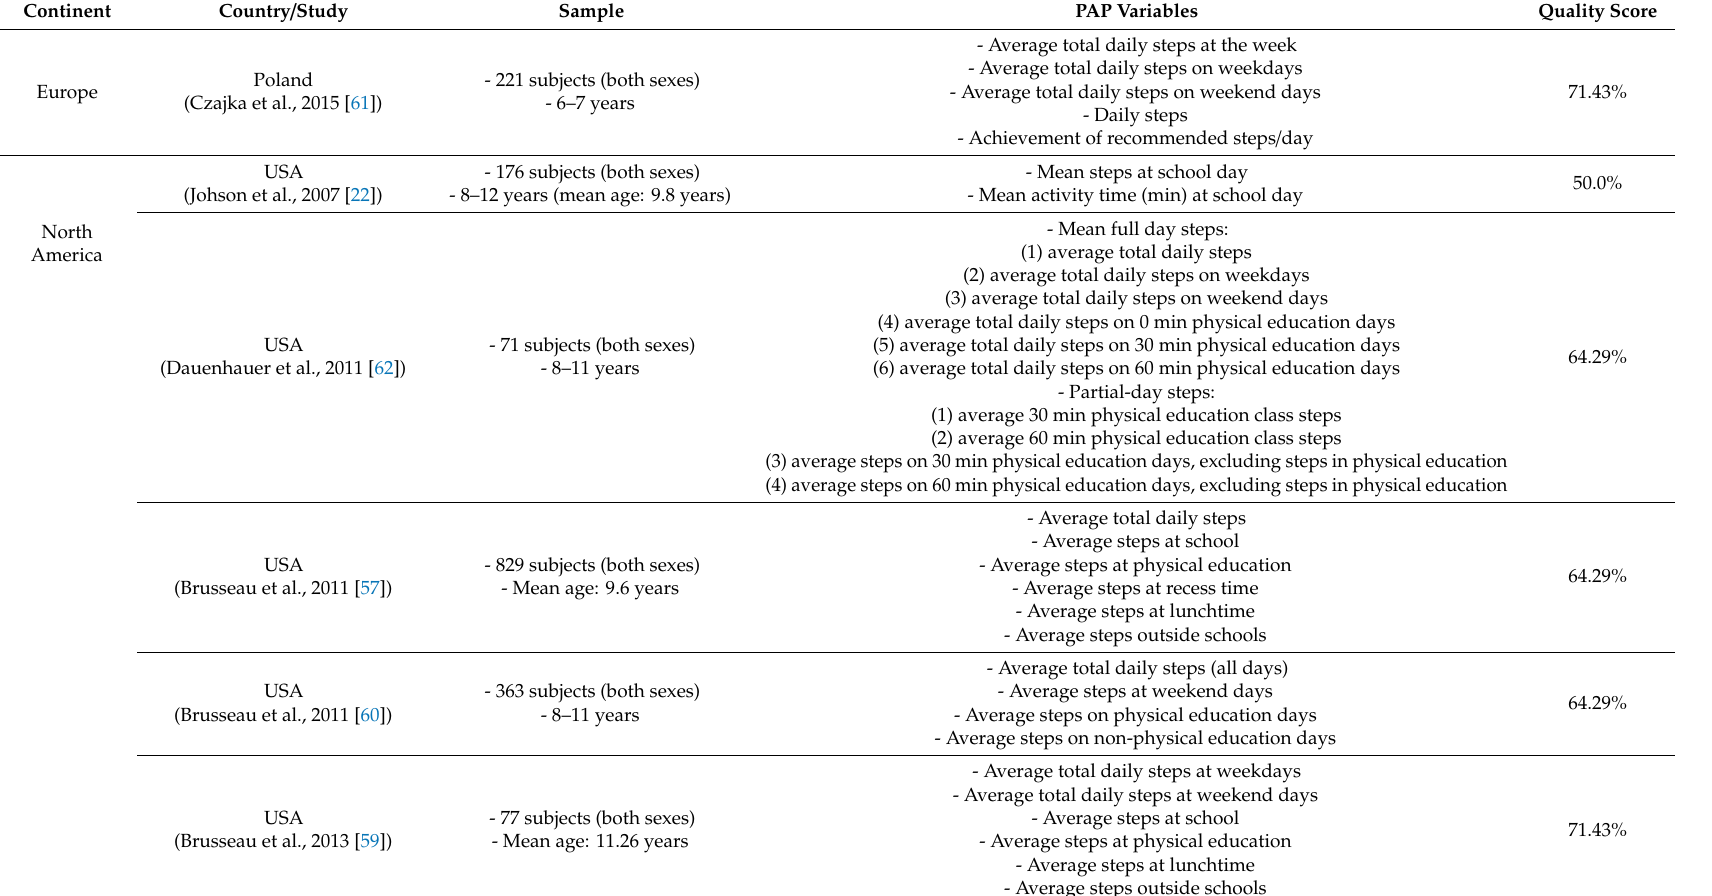
Table 3. Summary of the studies that used pedometers to assess